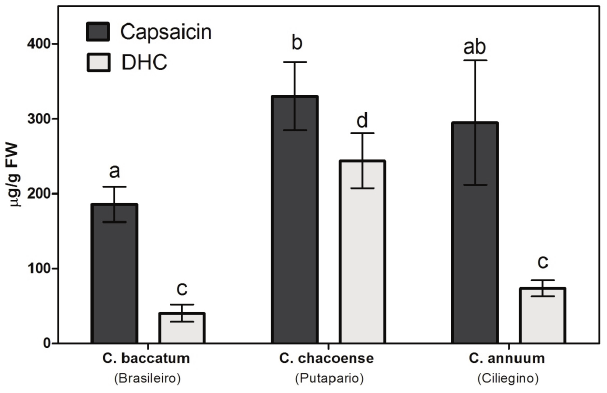
Fig. 1­ Capsaicin and dihydrocapsaicin (DHC) content obtained from ripe fresh pepper fruits for each species analyzed, using HPLC detection (n=5; SD). Different letters repre­ sent statistical significance (ANOVA, p<0.05).